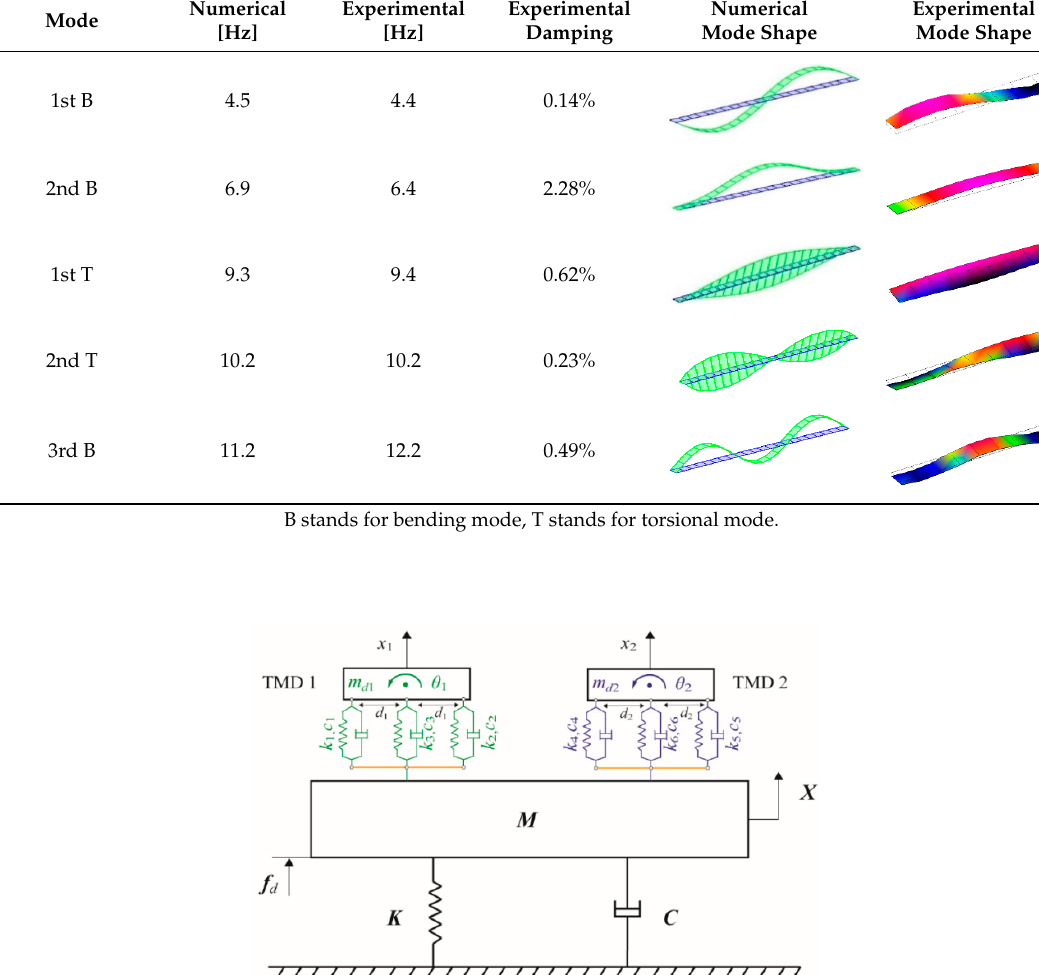
Figure 1. Concept model of the 2DOF TMDs: the bridge system equipped with two TMDs. The 2DOFs TMD is connected to the primary system at distances d 1 ( d 2 ) from its center of mass via dashpots and springs. Therefore, the control force vector [ u 1 , u 2 , …, u 6 ] in this case are given by: